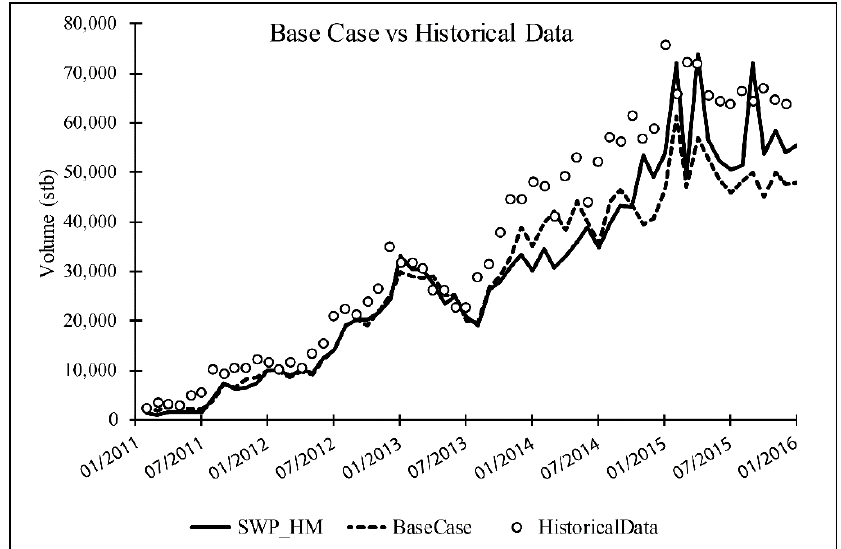
Figure 4. Plot shows the historical monthly oil production for the Farnsworth Units (black open circles), Base Case model forecasts (black dashed line), and history-matched model forecasts (SWP_HM) (solid black line). Both numerical models show a good data fit to the historical production data.